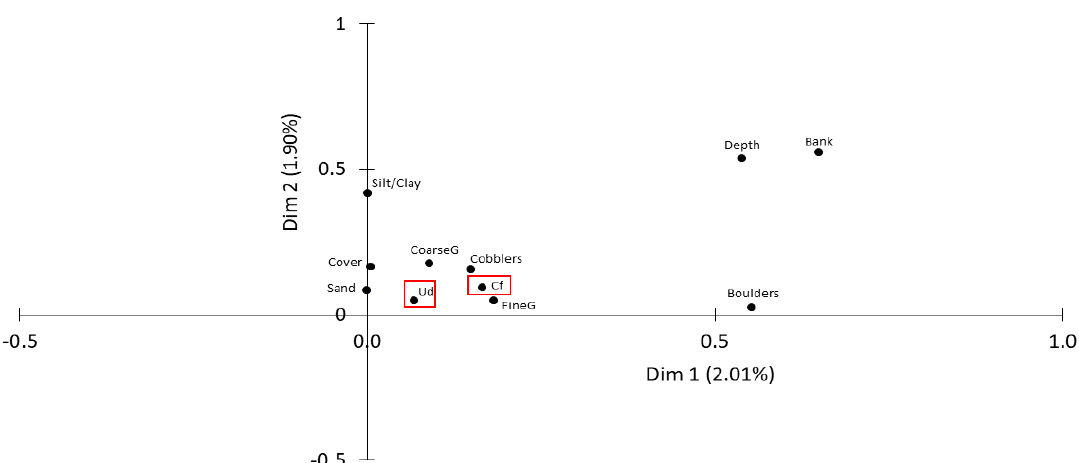
Figure 3. Multiple Correspondence Analysis (MCA) plot analysis for independent variables. Zoomed plot to 0.0 coordinates. Dim 1—Dimension 1 and Dim 2—Dimension 2. Dimensions represent categories with the highest contribution and the highest fraction of the total variance in the data. Codes for qualitative variables (presence/absence): Silt/Clay; Sand; FineG—fine gravel; CoarseG—coarse gravel; Cobblers; Boulders; Cover—Riparian gallery cover; Ud— U. delphinus species presence; Cf— C. fluminea species presence. Variable codes for quantitative variables (continuous): Bank—Distance to near margin (m); Depth—Water column depth (m).